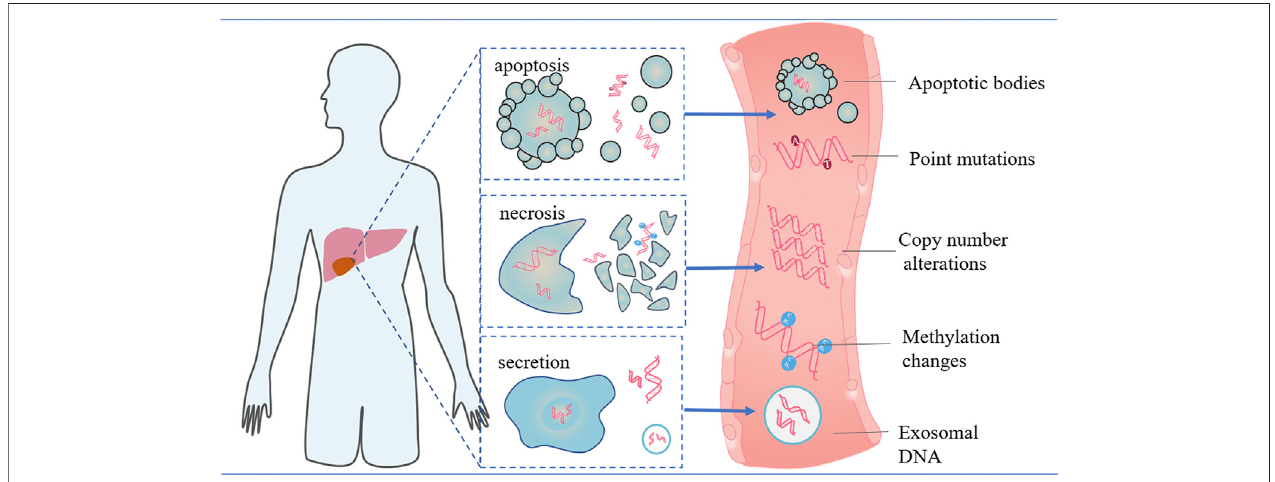
FIGURE 1 | Origin and range alterations of cfDNA. Cell-free DNA (cfDNA) is passively released by apoptotic or necrotic tumor cells and actively secreted by exosomes, which are membrane -bound vesicles released by tumor cells. Of these cells, apoptosis serves as the main source of cfDNA in both normal and diseased tissues. Analysis of these molecules can be employed for early tumor detection and may provide a prognostic treatment strategy for HCC patients.